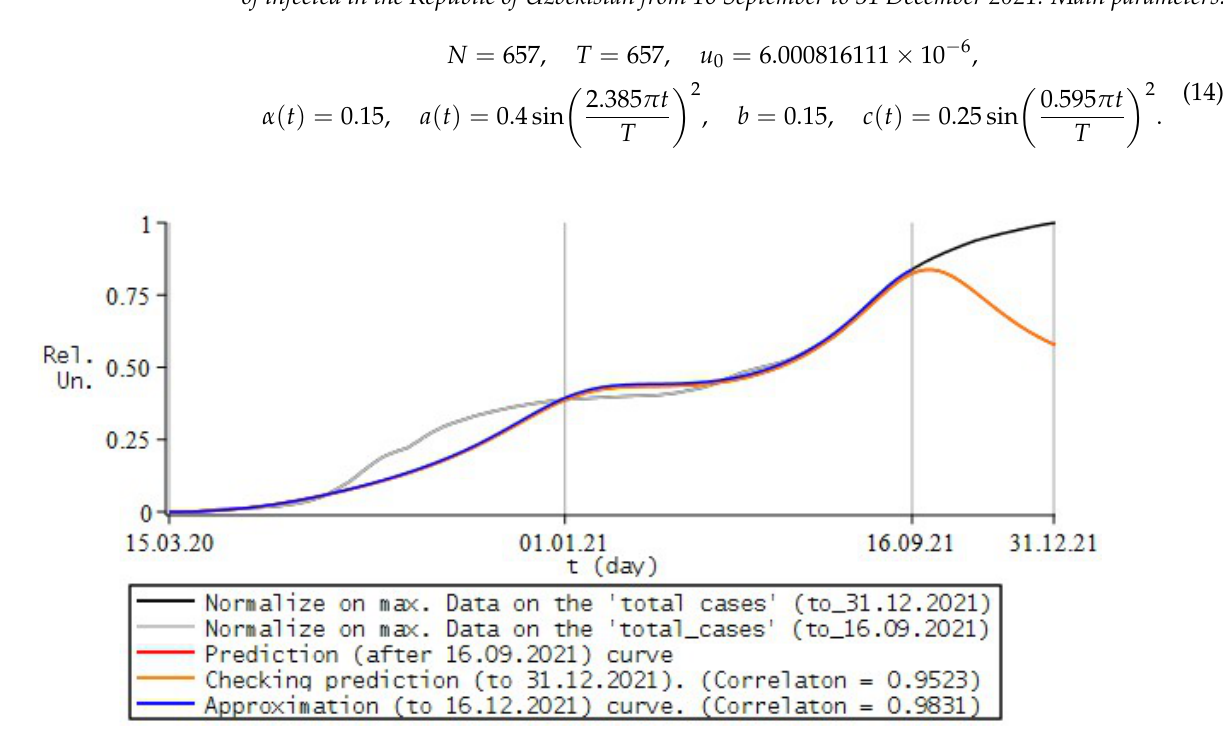
Figure 19. The Republic of Uzbekistan. Model curve: (blue)—approximation, with a correlation coefficient: 98.3%; (red)—forecast, through 31 December 2021; (orange)—verification of the forecast with the correlation coefficient: 95.2%. The red curve and the orange curve are obviously the